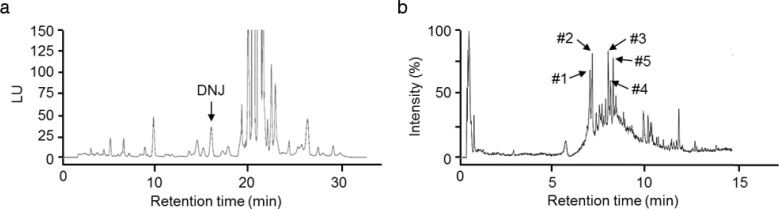
Representative chromatograms of MLE. (a) HPLC analysis of DNJ in MLE. (b) LC-MS analysis of phenolic compounds in MLE. Numbers refer to the main peaks identified: #1, 4-O-caffeoylquinic acid; #2, 1-O-caffeoylquinic acid; #3, kaempferol-3,7-diglucoside; #4, 6-hydroxykaempferol-3-O-glucoside; #5, genistein-7,4’-di-O-β-D-glucoside.